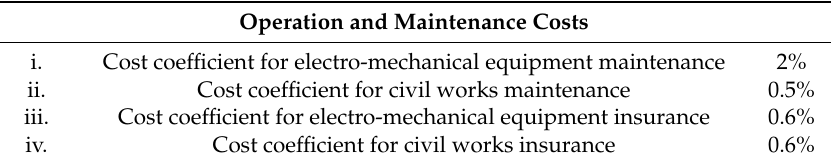
Table 5. Operation and maintenance costs for onshore wind power systems in Greece.